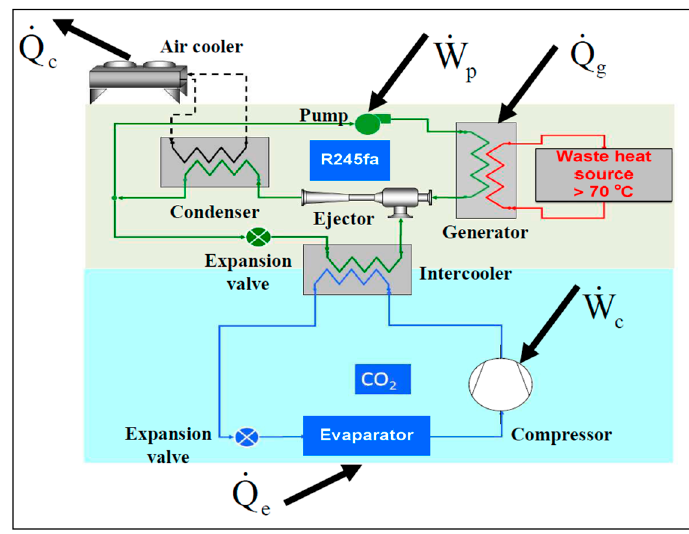
Figure 37. Ejector–compression cascade prototype [339].